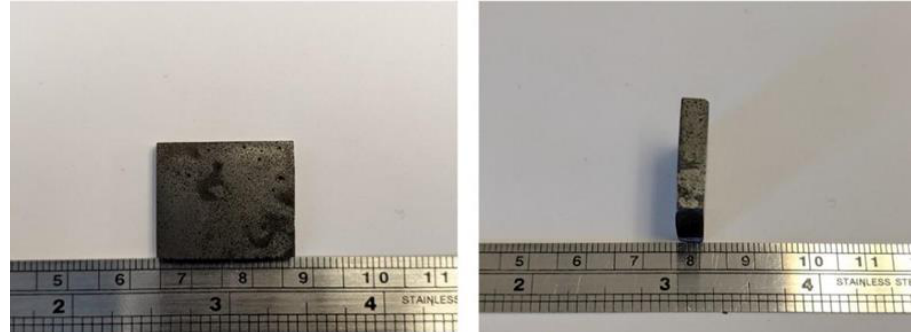
Figure 2. Cut and ground sample of cured magnetic composite created using dual-cure prepolymer reinforced with magnetic fillers.